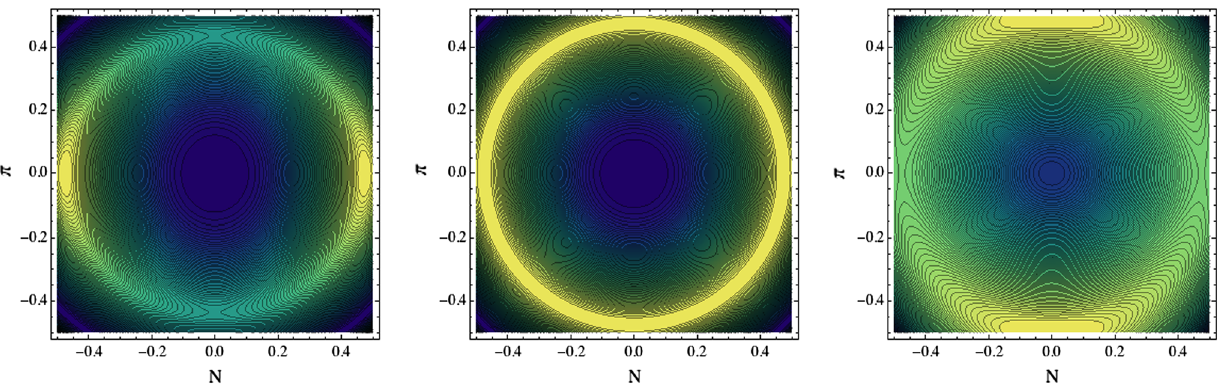
ishing vev and π = 0. Center: case with γ I = γ B = 1 . 15, the minimum has a degenerate O ( 2 ) symmetry. Right: case with γ I = 1 . 18. The π condenses while N =